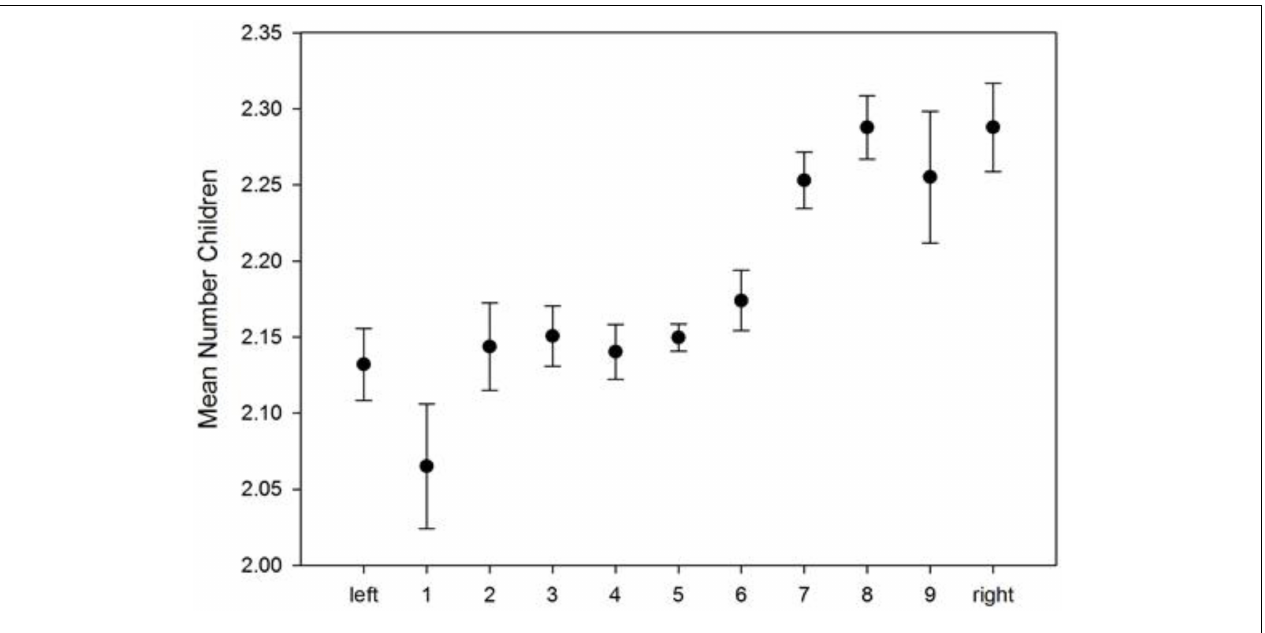
FIGURE 3 | SHARE data: political attitude and mean ( ± SE) number of